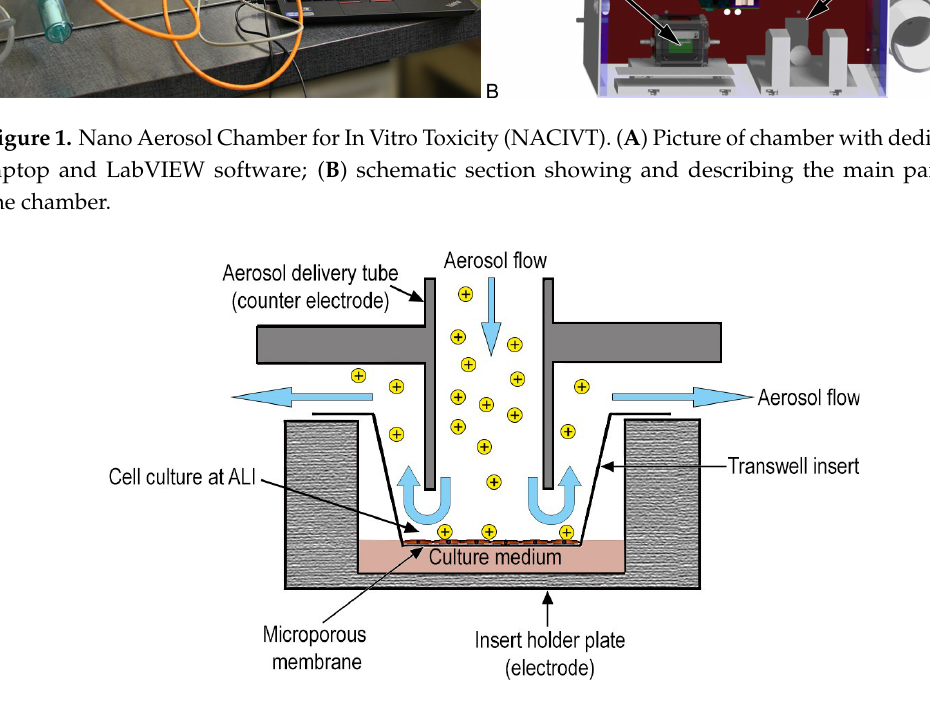
Figure 2. Particle delivery by electrostatic precipitation. Schematic section of an aerosol delivery tube, its Transwell ® insert and the insert-holder plate, demonstrating the aerosol flow and particle